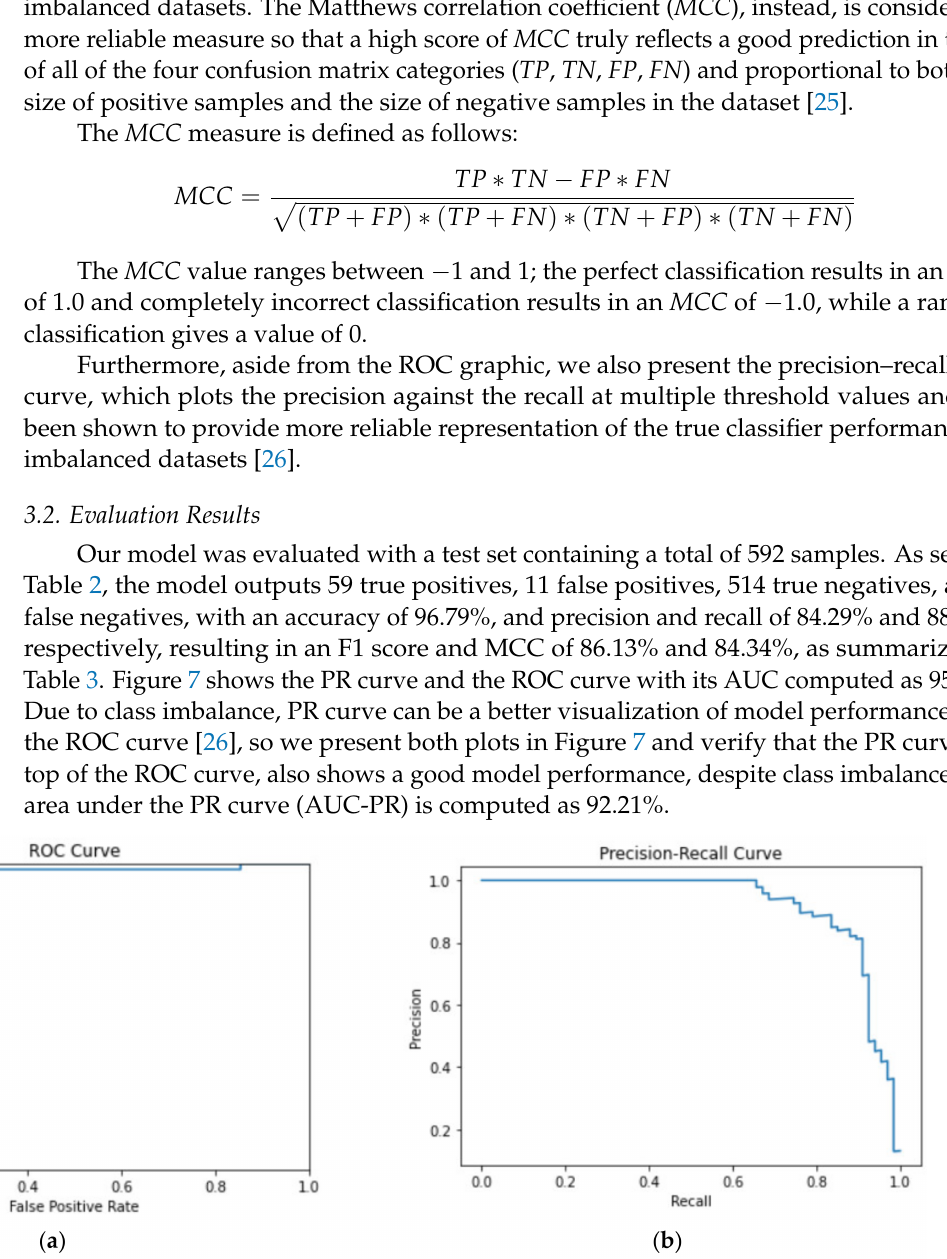
Figure 7. ROC curve performance of arrhythmia detection ( a ) ROC curve, and ( b ) PR